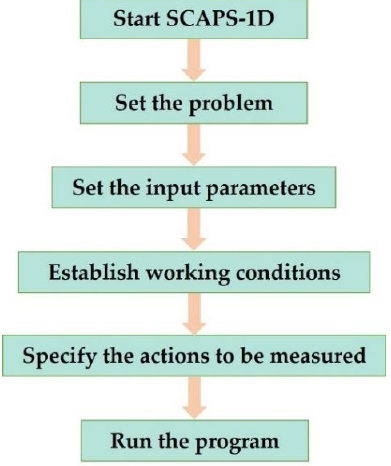
Figure 1. Steps to build and simulate a solar cell in SCAPS-1D.